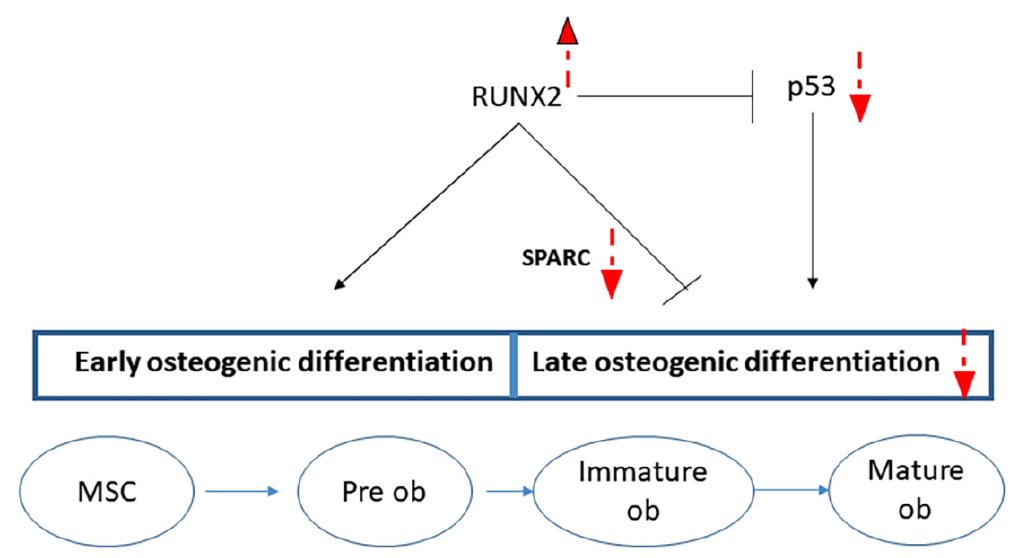
Figure 8. Schematic diagram showing (in red) the altered processes due to RUNX2 gene mutations in exon 7. Up (increased) and down (reduced) arrows showing the regulation in CCD patients